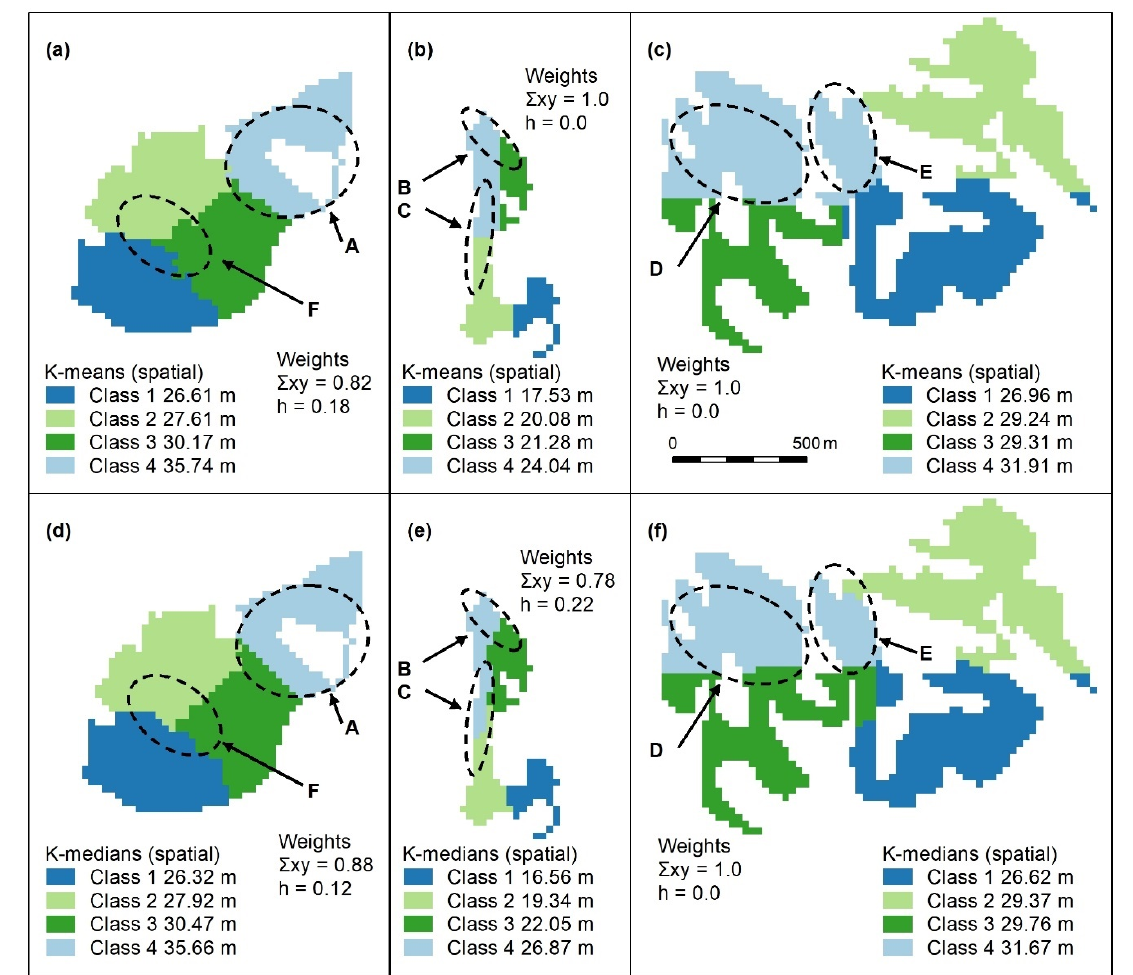
Figure A9. Spatially constrained K ‐ means ( a – c ) and K ‐ medians ( d – f ) cluster maps with 4 classes. Letters A–F indicate areas of higher canopy. Again, these algorithms use spatial weights ( x, y ) that far outweigh those of the object ( h = height). As with 3 classes for these algorithms, the only features adequately captured are A ( a , d ) and E ( c , f ). Panel scores: K ‐ means = 7 and K ‐ medians = 7.